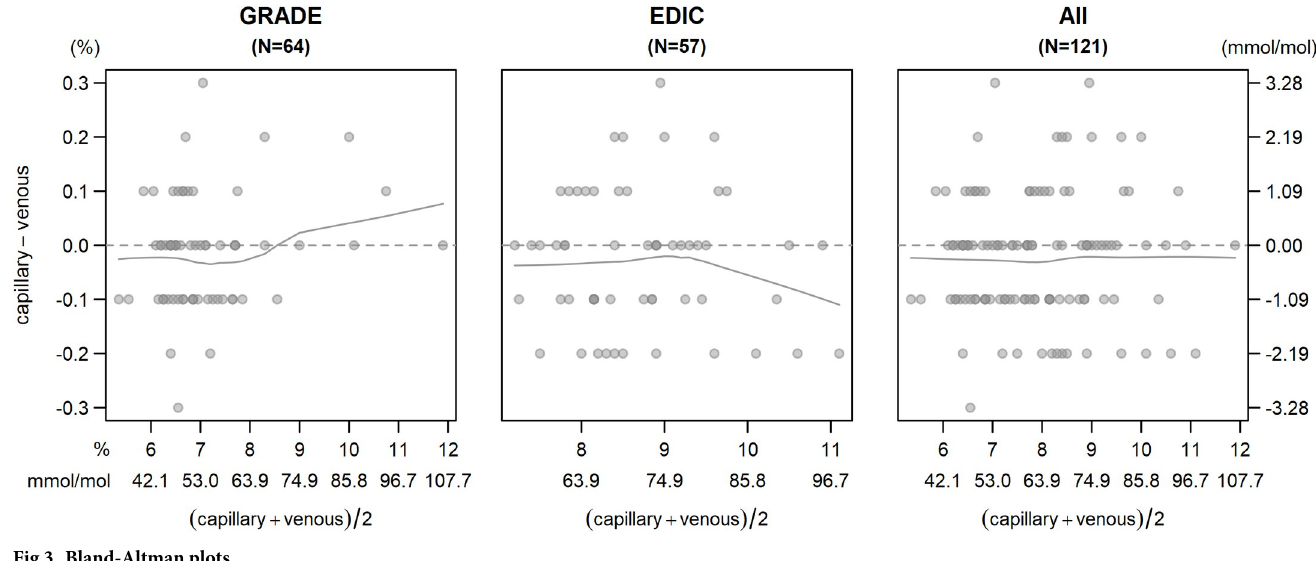
Fig 3. Bland-Altman